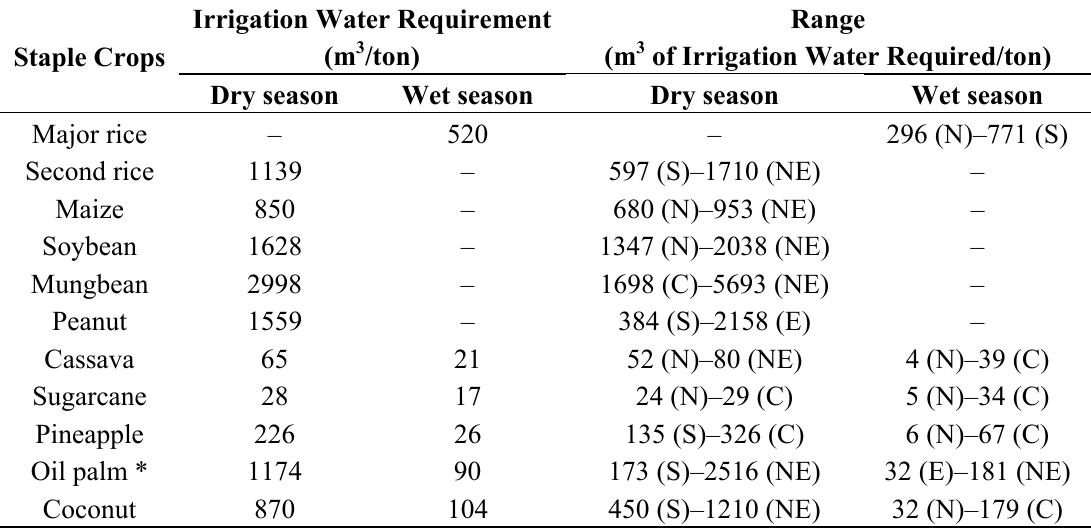
Table 3. Irrigation water requirement for staple crops production in Thailand.